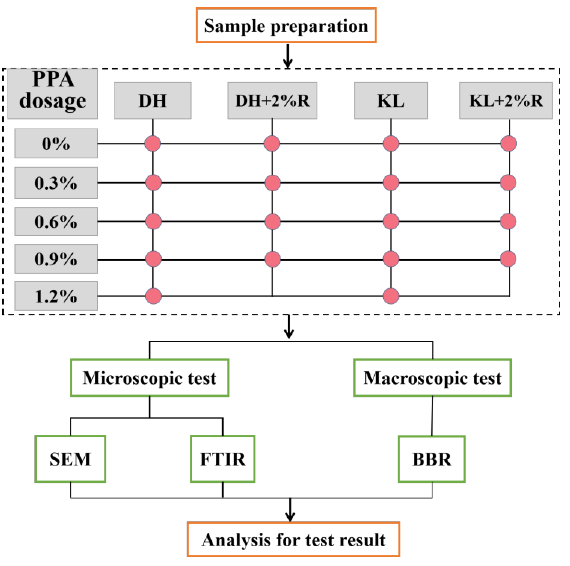
Figure 1. Experimental diagram of this